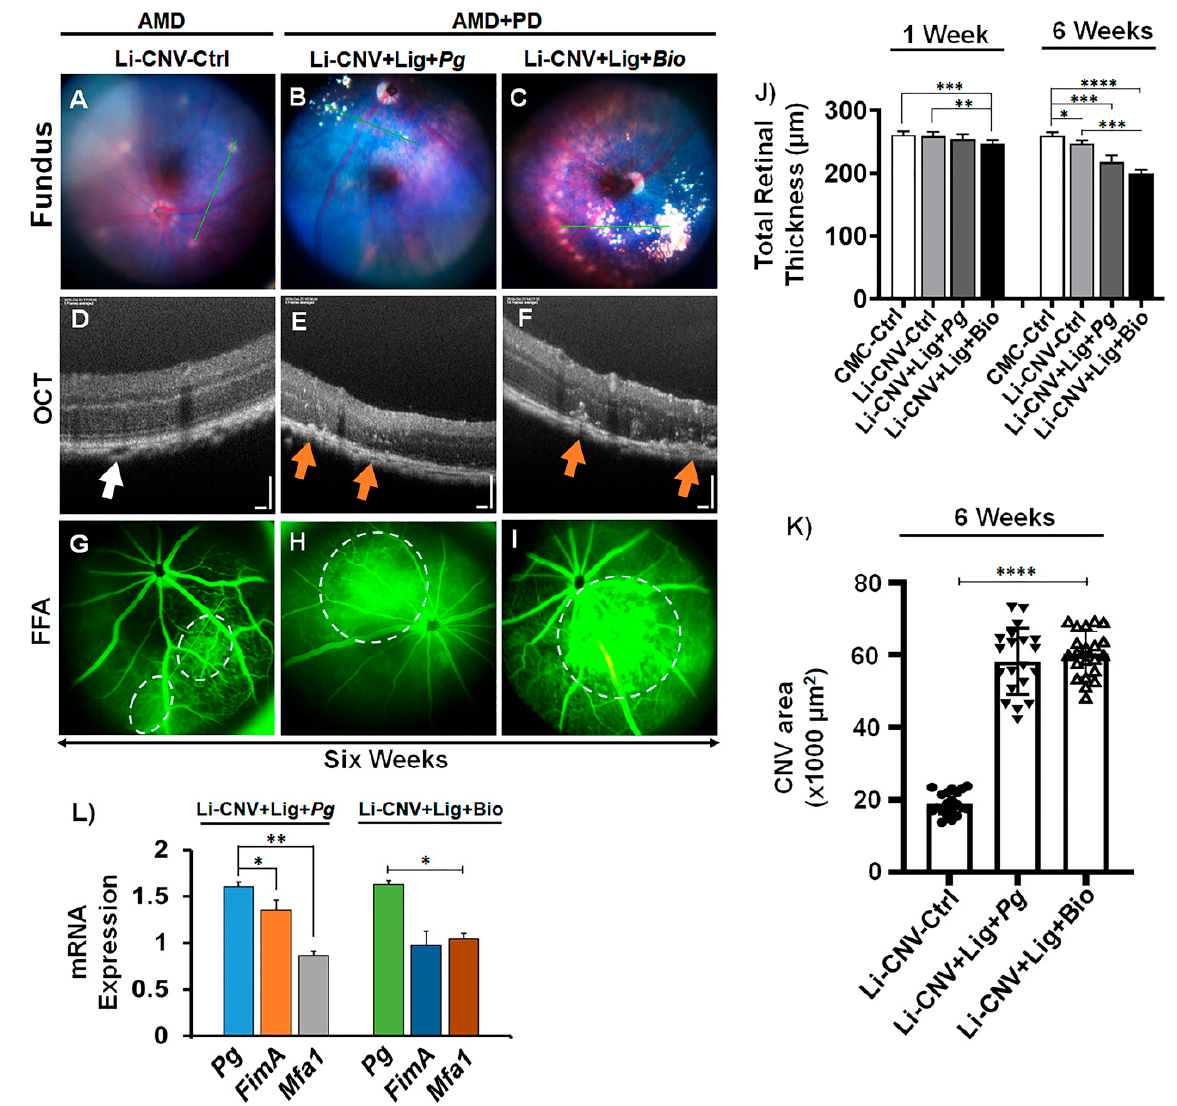
Figure 3. Progression of AMD pathogenesis through oral pathogens in AMD+PD mice retinae. Representative images of fundus ( A – C ), SD-OCT ( D – F ), and FFA ( G – I ) after 6 weeks of Li-CNV-Ctrl ( A , D , G ), Li-CNV+Lig+ Pg ( B , E , H ) and Li-CNV+Lig+Bio ( C , F , I ) infected mice retinae, respectively. ( A – C ) Fundus shows increased chronic CNV lesions and drusen-like deposits in chronic Pg - ( B ) and biofilm ( C )-infected retinae compared to CNV-control (A). Refer to Figure S2 for another set of representative fundus images. The green lines indicate the scan lines for the OCT sections. ( D – F ) OCT images further confirm chronic CNV lesion and drusenoid deposits located above the RPE in Pg - ( E ) and biofilm ( F )-infected retinae after 6 weeks with obvious reduction in retinal thickness and predominant vitreal (refer to Figure S2H,M, blue arrow) and subretinal angiogenesis compared to CNV control ( D , white arrow). Representative OCT scans show multiple subretinal and cuticular drusen-like depositions (orange arrows). Refer to the low magnification in Figure S2 for a complete view. ( G – I ) FFA shows increased blood leakage (dotted white circle) after 6 weeks compared to CNV and 1 week (Figure 1J–L). Refer to Figure S2 for another set of representative FFA images. ( J ) Quantification of total retinal thickness in Pg- and biofilm-infected mice at 1 and 6 weeks, compared to CMC and CNV controls. Total retinal thickness measured from the nerve fiber layer to the RPE layer. Mean ± SEM analyzed by one-way ANOVA followed by Tukey’s multiple comparisons test ( n = 24; **** p < 0.0001; *** p < 0.001; and ** p < 0.01). ( K ) Quantification analyses show increased CNV areas in Pg- and biofilm-infected mice retinae after 6 weeks compared to CNV control. Mean ± SEM analyzed by one-way ANOVA followed by Dunnett’s multiple comparisons test ( n = 18, **** p < 0.0001). ( L ) qPCR shows mRNA expression of Pg , FimA , and Mfa1 in Pg alone and biofilm orally infected mice retinae and untreated controls, normalized with the internal (universal 16S-rRNA) control and compared to Pg vs. Mfa1 and FimA genes ( n = 12; ** p < 0.01).